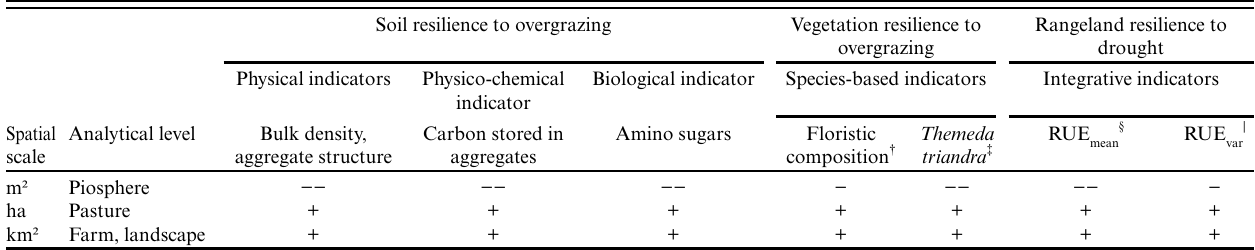
Table 2. Resilience of the current ecological subsystem, specified for relevant analytical levels on the spatial scale. For soil and vegetation resilience to overgrazing, observations are benchmarked against the rangeland state on adjacent commercial farms. Results from the spatial level of pastures (outside piospheres) are used to generalize findings to the landscape level. Drought resilience is benchmarked against a desirable (experimental) pasture state. Positive signs (+) represent small differences compared to the benchmark state and thus comparatively high resilience; negative signs represent large (−) or very large (−−) differences and thus low